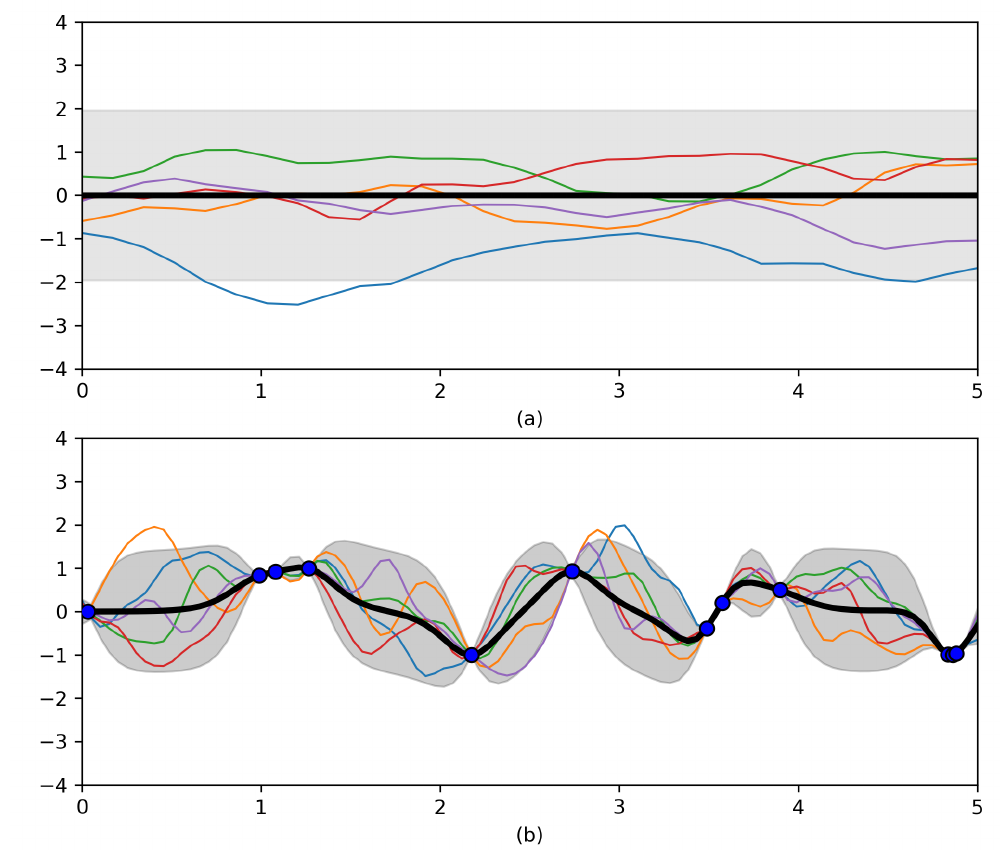
Figure 4. ( a ) Five samples from a rational quadratic function prior. ( b ) Five samples from the posterior after conditioning on twelve noise-free datapoints obtained from f ( x ) = sin ( x 2 )